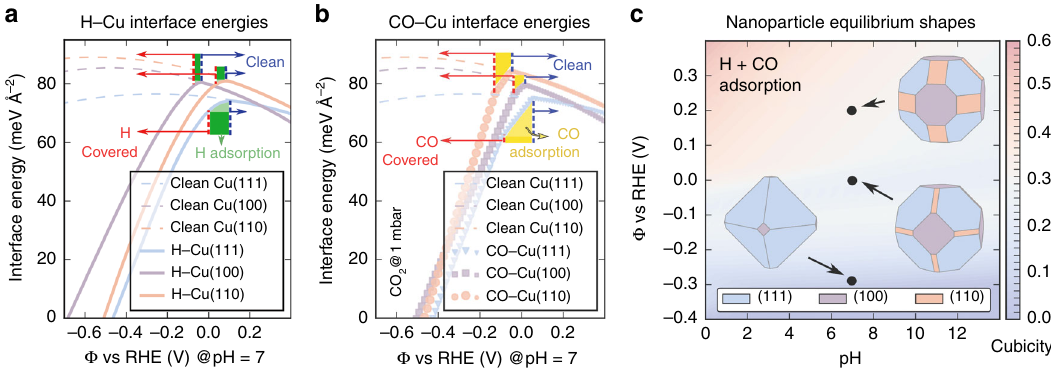
Fig. 5 Theoretical DFT investigations. a , b Grand potential interface energies for a H-covered and b CO-covered Cu surfaces in aqueous solution. c pH and potential dependence of the Wulff-shape of Cu nanoparticles including H, CO, and mixed H + CO covered surfaces. Please note that the inaccuracy of our potential scale is around 0.3 V (see Supplementary Methods for details). The cubicity is de fi ned as the relative contribution of Cu (100) surfaces to